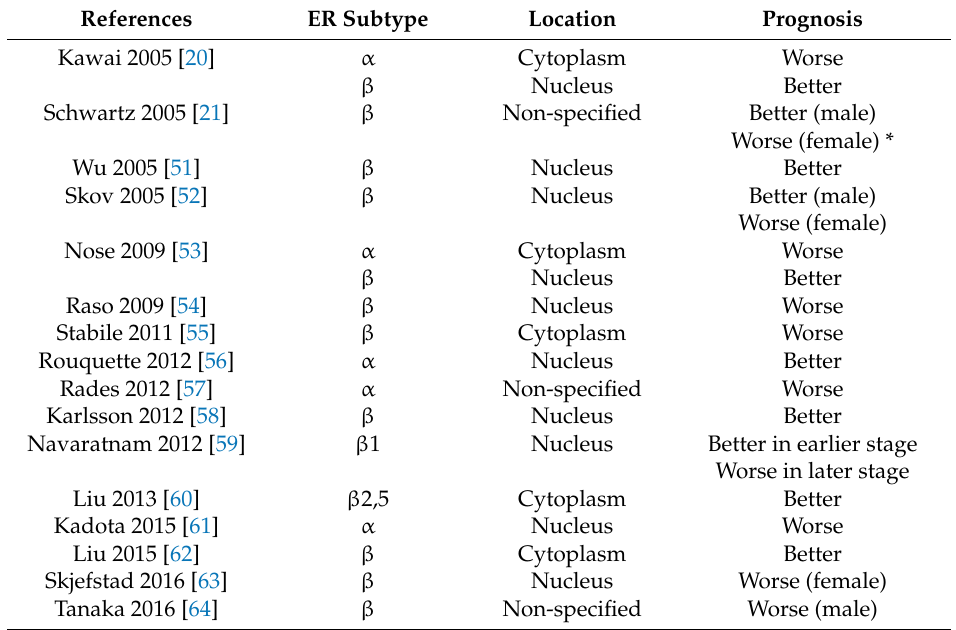
Table 1. Estrogen receptor (ER) detected by immune-histochemical stain as prognosticators in